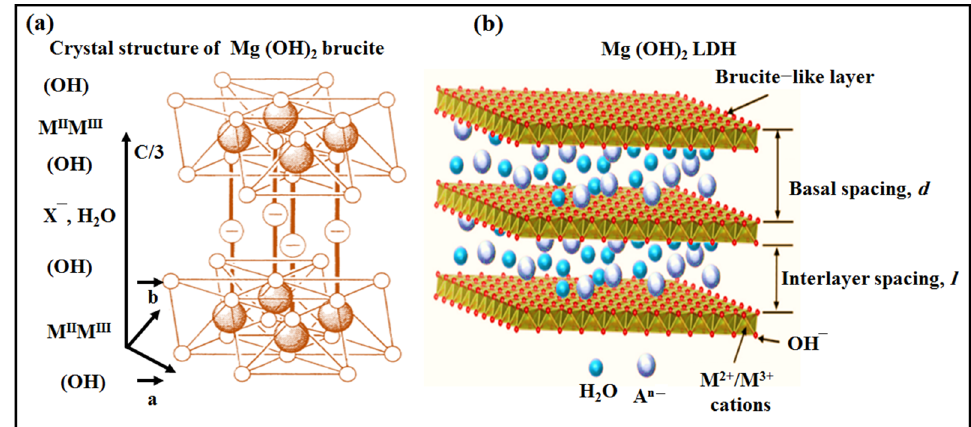
Figure 2. Structures of ( a ) Mg (OH) 2 brucite (Adopted from Cavani et al. [59], with permission from Elsevier) and ( b ) LDH (Reprinted with permission from Ref. [60]. Copyright 2020, MDPI).